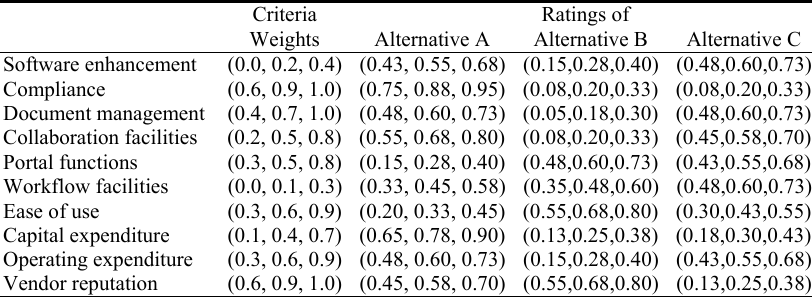
Table 7. Aggregate fuzzy criteria weights and alternatives